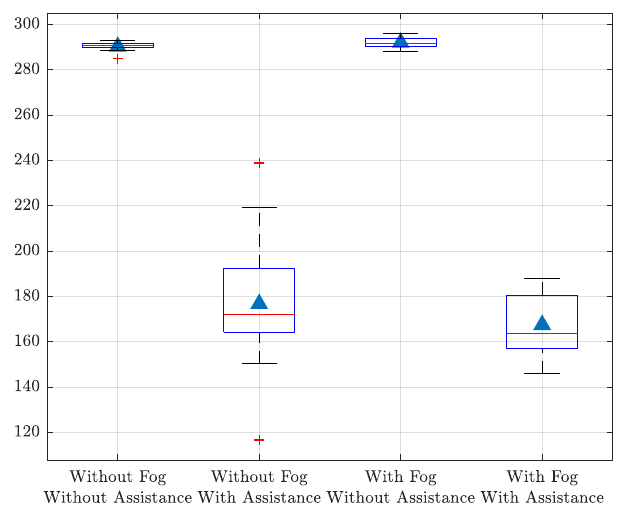
Figure 8. Driver steering torque